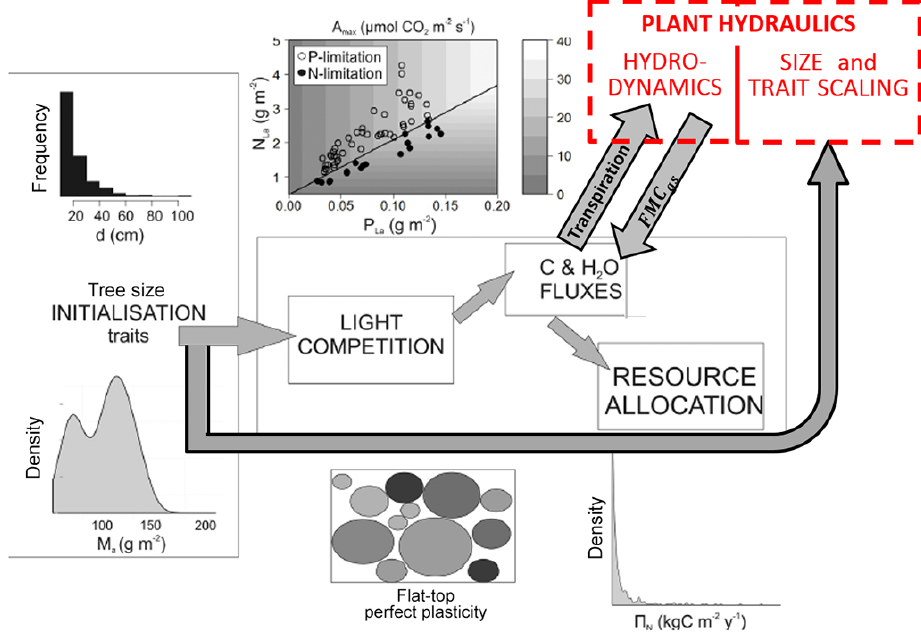
Figure 1. Overview of TFS v.1-Hydro model. Left panel: inputs are plot observations of the tree size distribution and distributions of each of four plant functional traits (WD, LMA, N L , P L ) . Middle bottom: the perfect plasticity approximation (PPA) orders trees by decreasing crown area. Middle top: TFS assigns physiological traits, such as V c , max , to each tree based on functional traits. Middle: the PPA is used to estimate light environments of each tree, which influence fast-timescale (hourly) biophysics of crown light interception, photosynthesis, and stomatal conductance. Assimilated carbon is allocated to leaves, stems, and fine roots daily. Top right (hydrodynamics): soil–root–stem–canopy water fluxes interact with fast-timescale TFS biophysics by taking transpiration as a boundary condition and passing back the fraction of maximum conductance (FMC gs ) for downregulating the next time step’s stomatal conductance based on leaf water potential. Top right (size and trait scaling): hydraulic traits in leaves, stem, and roots are assigned based on each tree’s height and trait values according to empirical equations and allometric theory described in this paper. Bottom right: TFS predicts a distribution of individual tree net primary productivities. See Supplement Fig. S1.1 for the structure of the plant hydraulics